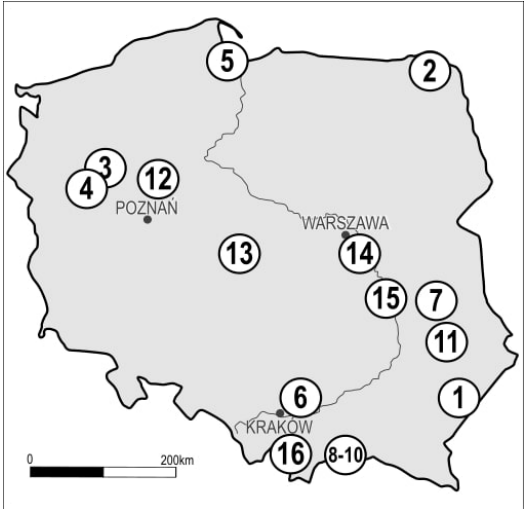
Figure 1. The location of the study area. 1. Bolestraszyce, 2. Bród Nowy, 3. Bucharzewo, 4. Chorz ę powo, 5. Gda ń sk-Oliwa, 6. Kraków, 7. Lublin, 8. Muszyna (Ogrody Biblijne), 9. Muszyna (Ogrody Magiczne), 10. Muszyna (Ogrody Sensoryczne), 11. Osmolice, 12. Owi ń ska, 13. Podd ę bice, 14. Powsin, 15. Trzcianki, 16. Zawoja (Babiogorski National Park) . Details of the sites included in the study are summarised in Table 1. The number of sensory gardens located in towns/cities and villages is comparable (7 and 8). Gardens from large cities (over 500,000 inhabitants) as well as from smaller towns and villages with very low populations were included. Both privately owned facilities and those managed by state institutions and local authorities were included. At the moment of conducting the study, these were all of the sensory gardens in Poland. Table 1. Details of the location and type of sensory gardens included in the study . Location of the Sensory Garden Type of Environment